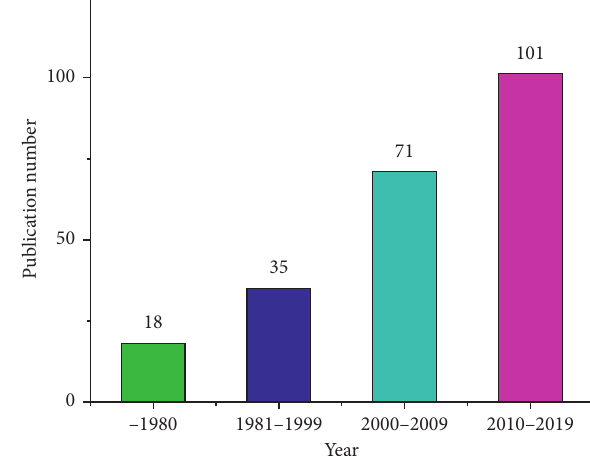
Figure 1: Histogram of research papers on gear vibration and